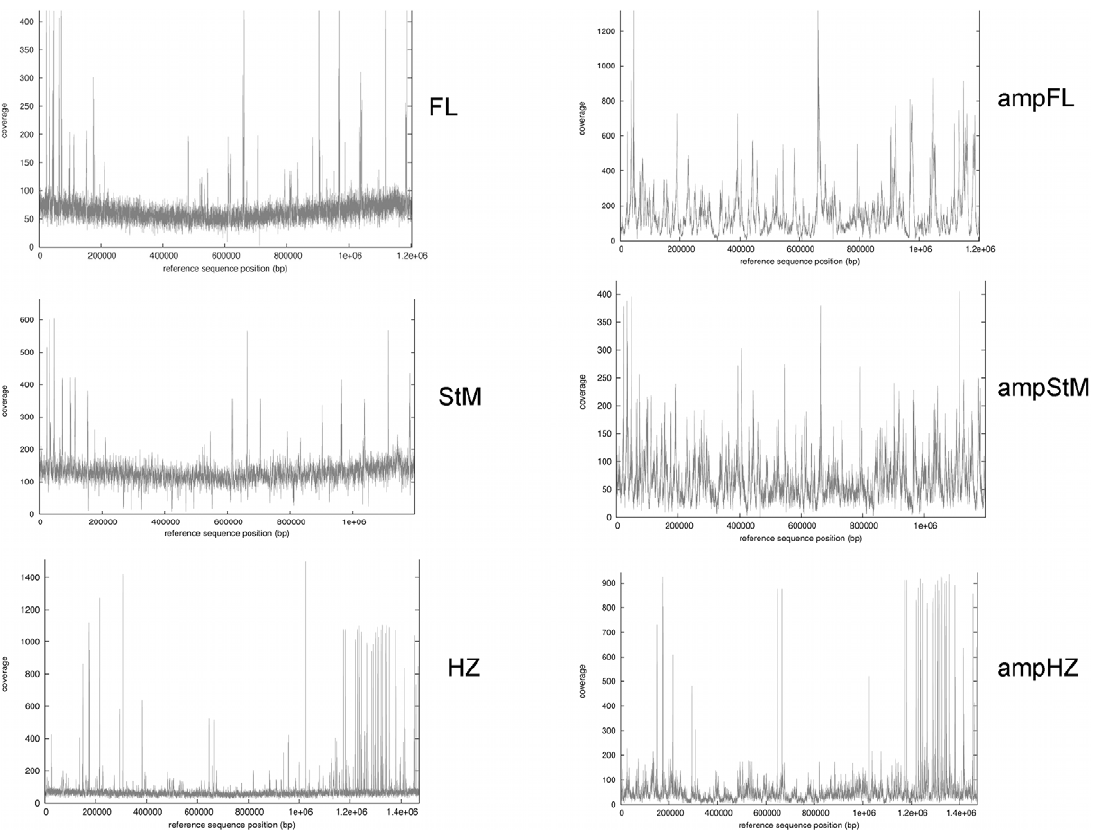
Figure 1. Genome coverage graphs of Florida (FL) and St. Maries, Idaho (StM) strains of A.marginale or the HZ strain of A. phagocytophilum . Sequencing reads derived from either amplified or nonamplified genomic DNA were aligned with the respective homologous reference genomes using Mosaik. Coverage was obtained across the entire genomes, although coverage levels were more variable with respect to genome location using amplified